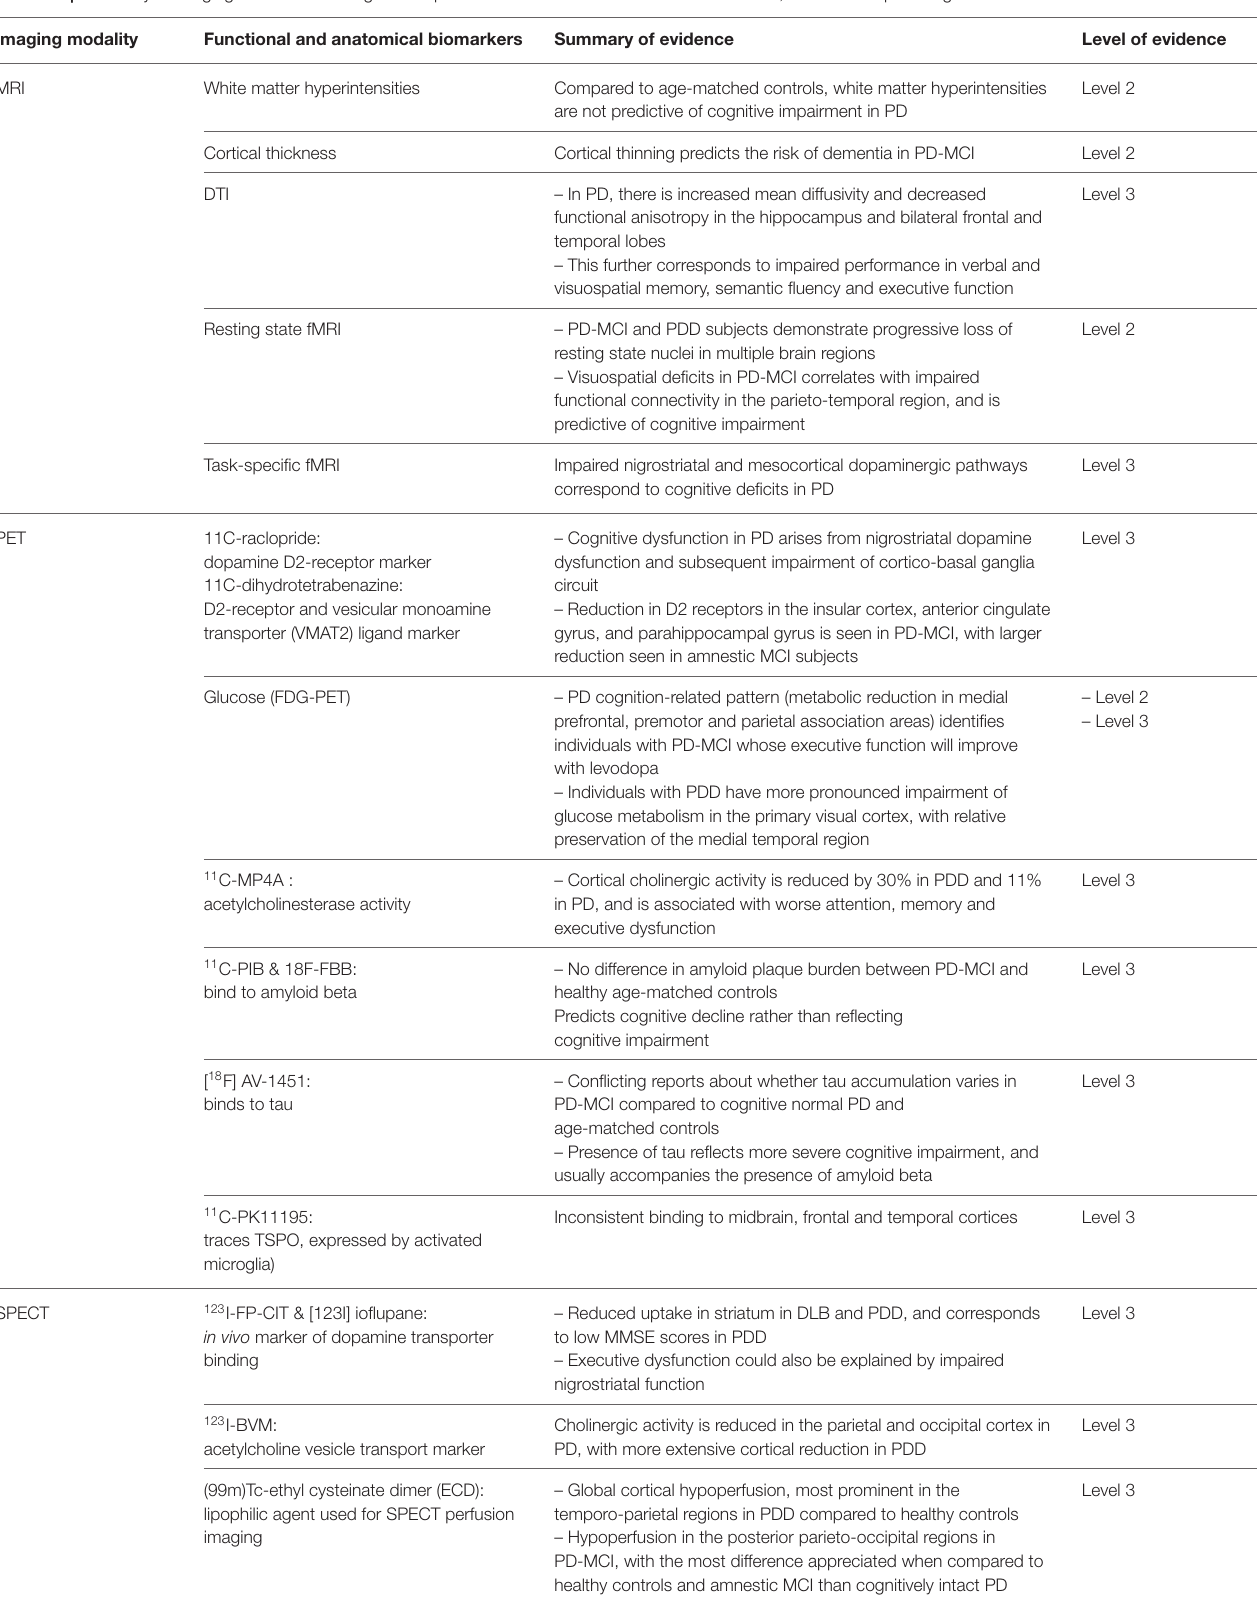
TABLE 1 | Summary of imaging biomarkers in cognitive impairment and dementia in Parkinson’s Disease, with their respective grades of evidence. Imaging